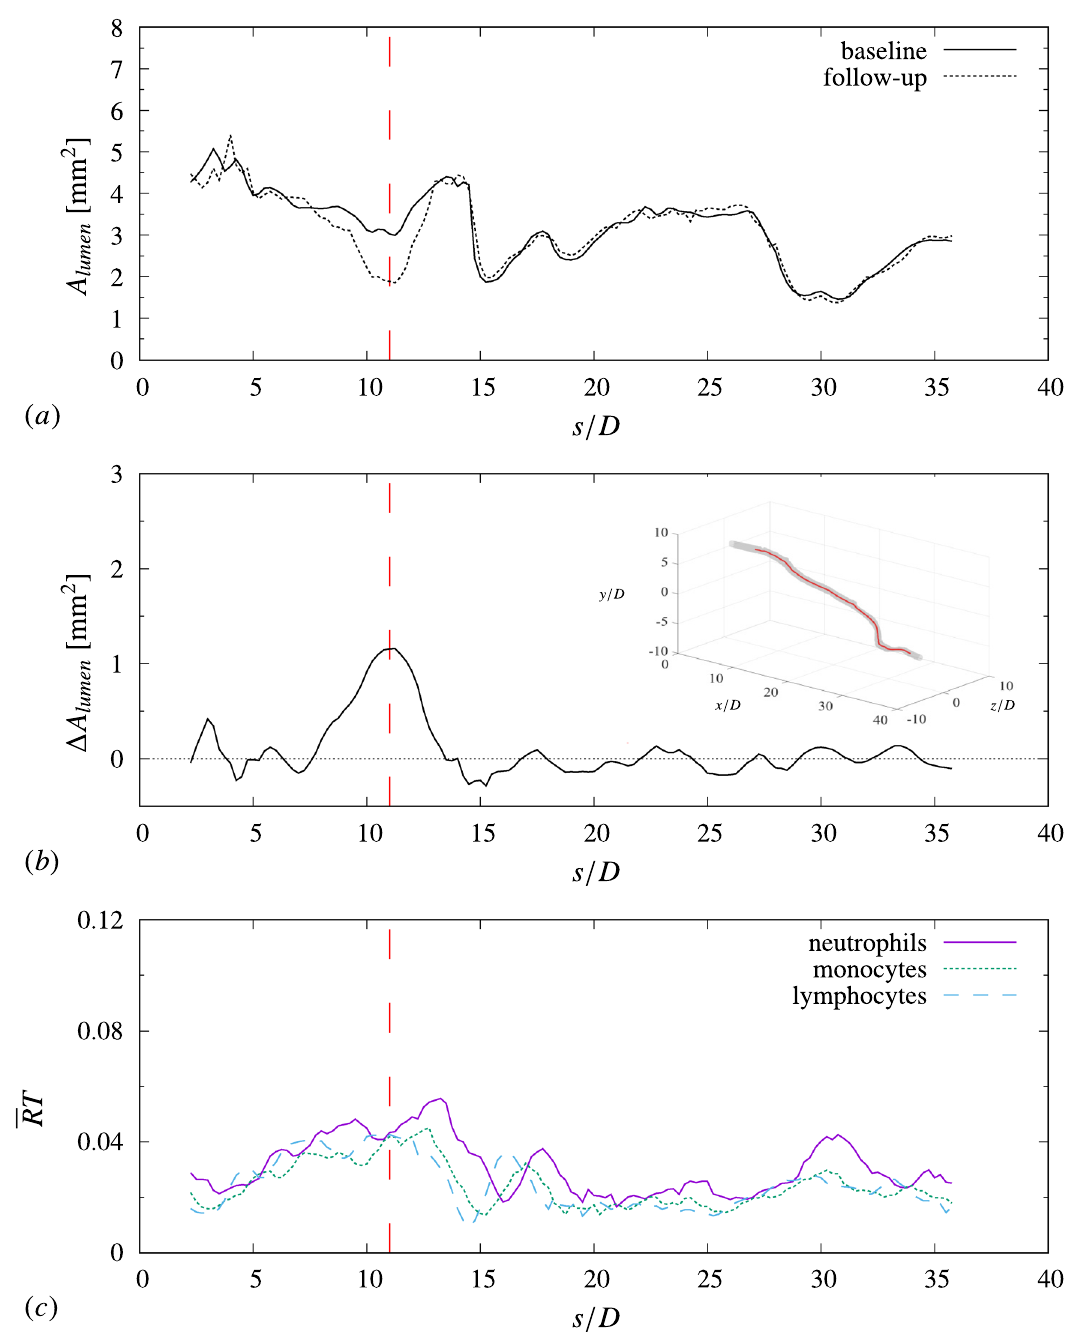
to follow-up, (cid:31) A lumen = A baseline − A follow − up . A positive value indicates reduction of lumen area (hence plaque growth and disease progression). ( c ) Predicted mean rate of adhesion for three different species of leukocytes. T indicates the cardiac cycle ( T = 0.8s in this study), R is the adhesion rate. The vertical dashed red lines indicates the location of maximum lumen area change from the baseline to the follow-up